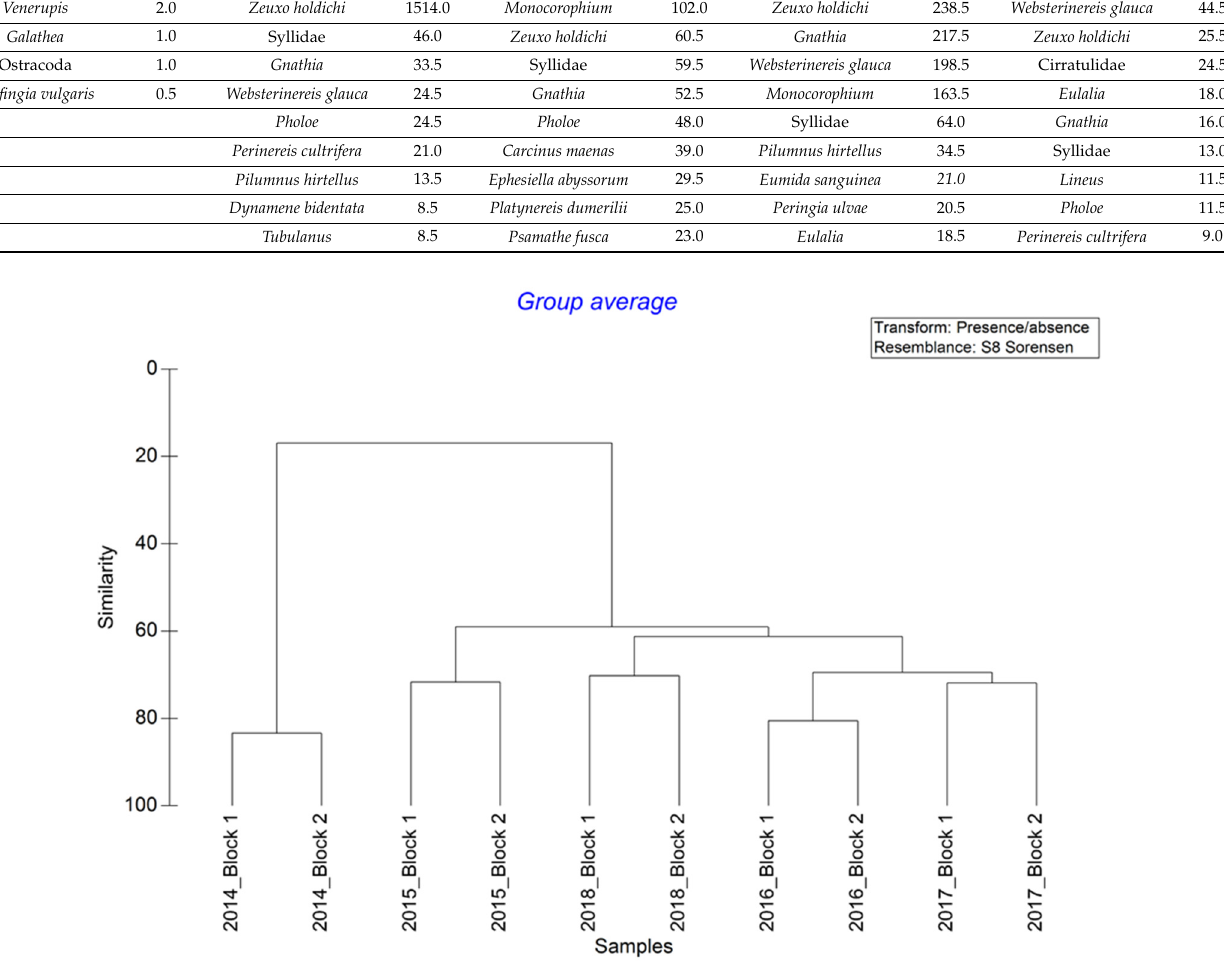
Figure 8. Hierarchical Cluster Analysis (HCA) using the mean grouping method (UPGMA) and based on Sorensen’s coefficient for the presence/absence of the 84 taxa found on the ten blocks during the 2014–2018 study (superscript: same letters in adjacent columns indicate no significant statistical difference between blocks and years).